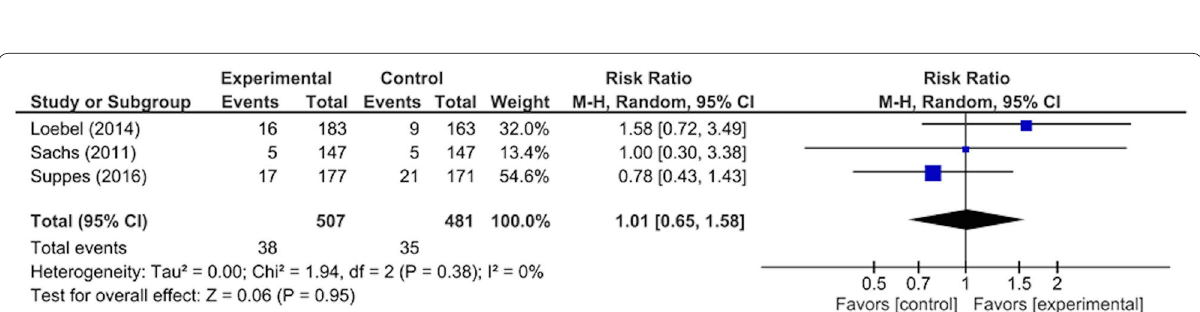
Fig. 7 Forest plot of post-intervention treatment effect sizes for emergence of suicide-related behaviors. CI, confidence interval; SD, standard deviation; MS, mood stabilizers, including lamotrigine, lithium, and valproate; SGA, second-generation